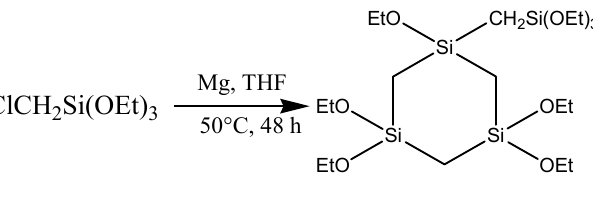
Figure 2. Synthesis of cyclic-bridged organosilane